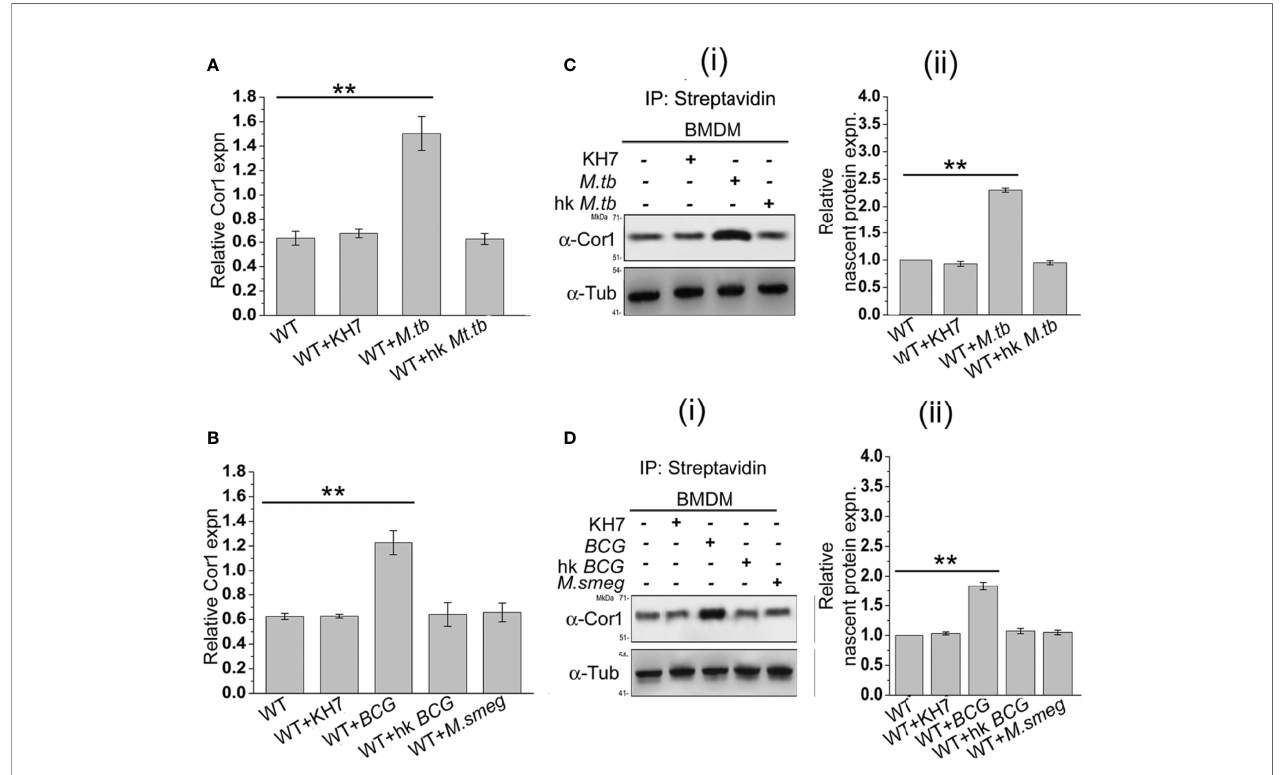
FIGURE 3 | (A) Relative Cor1 expression against control b-tubulin expression in BMDM when kept uninfected, KH7 treated or (A) live M. tb , heat-killed M. tb infected or (B) live M. bovis BCG , heat-killed M. bovis BCG , or live M. smeg infected BMDM. Infection was carried out with MOI of 1:20 for 3 h (n = 3). (C) Nascent proteins labelled with L-AZA and thereafter biotinylated were immunoprecipitated using streptavidin=agarose and then immunoblotted with anti-Cor1. Immunoblots and their corresponding densitometric analysis were carried out for BMDM, which were either untreated or treated with KH7 or (C) (i), (ii) infected with live M. tb , heat-killed M. tb , or (D ) (i), (ii) infected with live M. bovis BCG , heat-killed M. bovis BCG , or live M. smeg , respectively (n = 3). Data represents mean ± SEM; ** p <